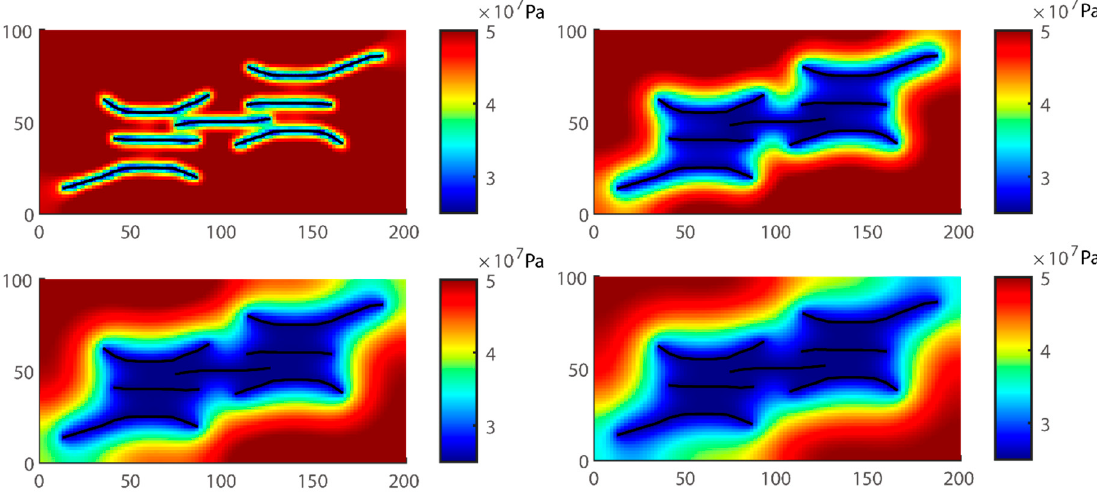
Figure 15. Pressure field after 30, 300, 600, and 900 days.